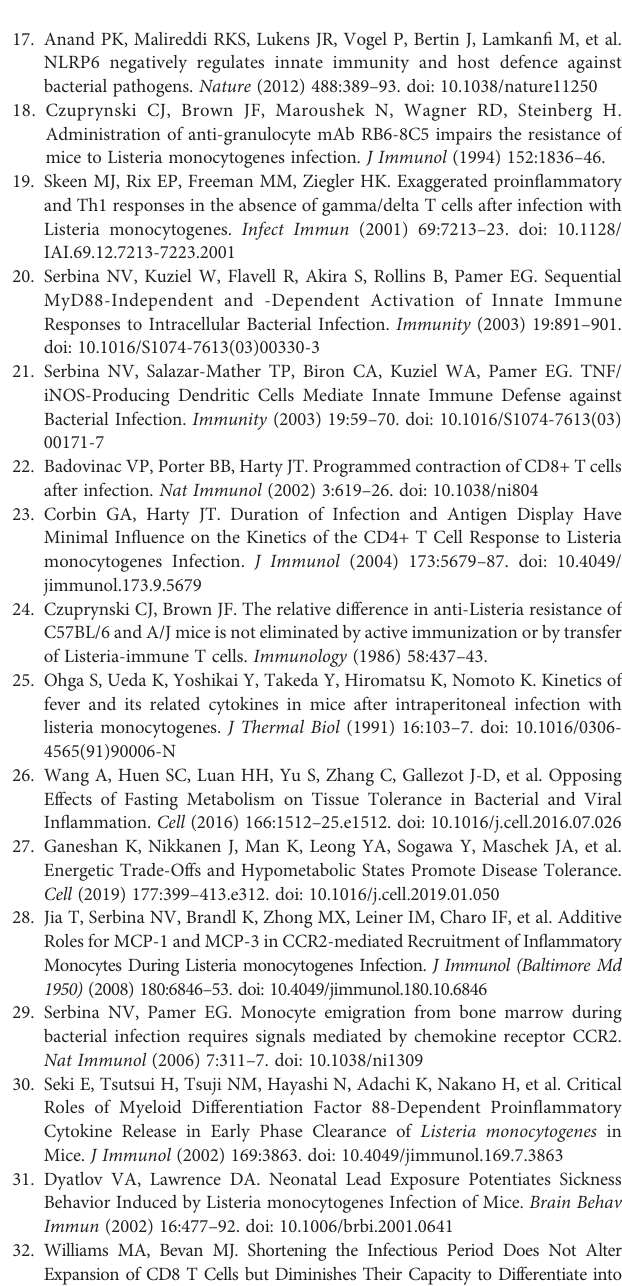
Supplementary Figure 1 | Gating strategy for Ly6C fl ow cytometric analysis. (A) Live cell gate created based on forward and side scatter. (B) Live cells were analyzed for doublet exclusion based on forward scatter height vs. forward scatter area. Cells within the indicated gate were further analyzed for (C) Ly6C and Glut1 expression. Ly6C+ cells were included based on gate set on negative control and (D) were further divided based on level of Ly6C staining into Ly6C hi and Ly6C int . (E) Glut1 staining on Ly6C int and (F) Ly6C hi cells based on control gates. Supplementary Figure 2 | Total CD3+ cell counts and gating strategy for CD3 analysis. (A) Number of CD3+ cells per spleen. (B) Number of CD3+ cells expressing Glut1. (C) Gating strategy indicating cells selected